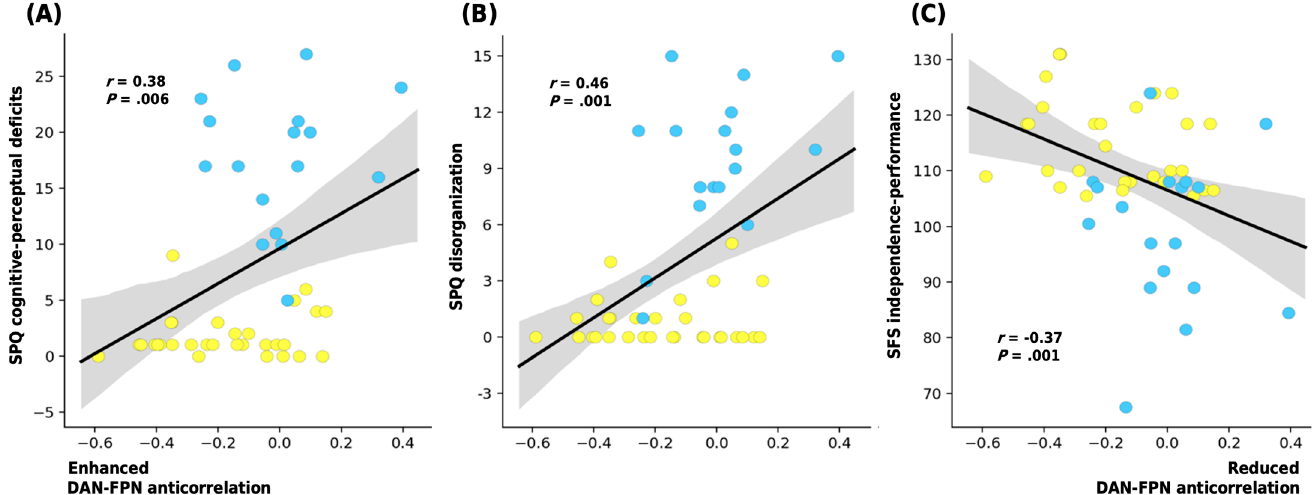
Figure 4. Plots displaying the correlation between the connectivity strength of R FEF of DAN and RpPC of FPN (the Z-value of peak DAN and FPN anticorrelation) with the participants’ ( A ) SPQ cognitive-perceptual deficits, ( B ) SPQ disorganization, and ( C ) SFS independence-performance scores. Shaded areas illustrate a 95% confidence interval; Pearson’s correlation coefficient (r) is also provided (SPQ: Schizotypal Personality Questionnaire; SFS: Social Functioning Scale, SPD: schizotypal personality disorder).